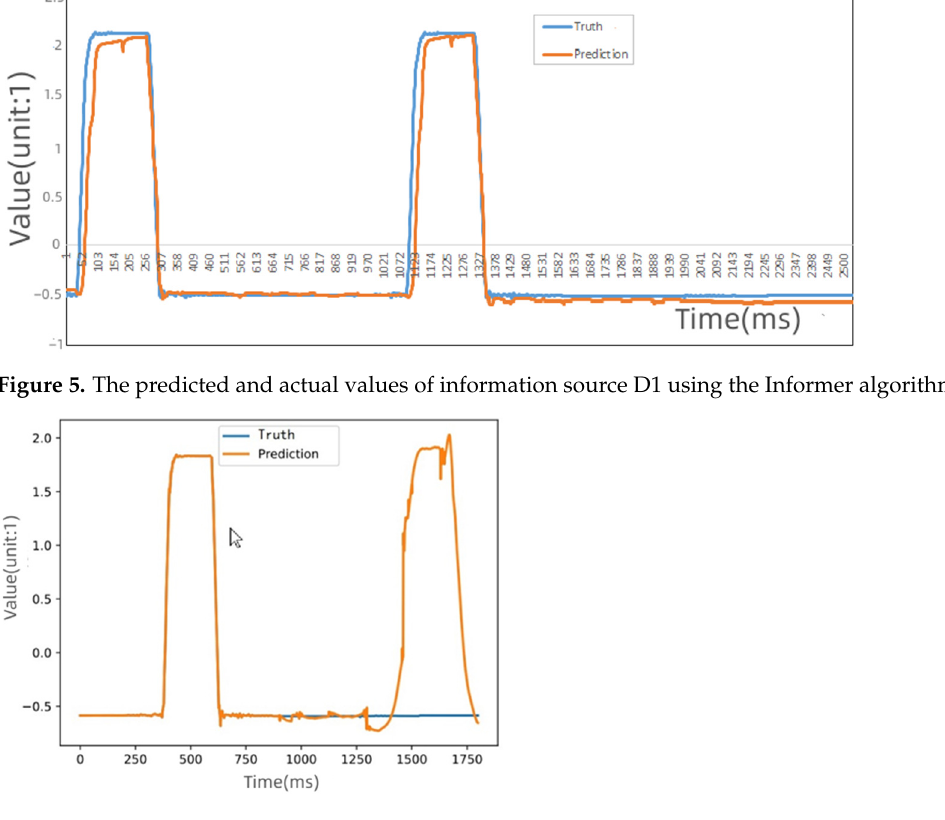
Figure 6. The predicted and actual values of information source D1 using the Autoformer algorithm.